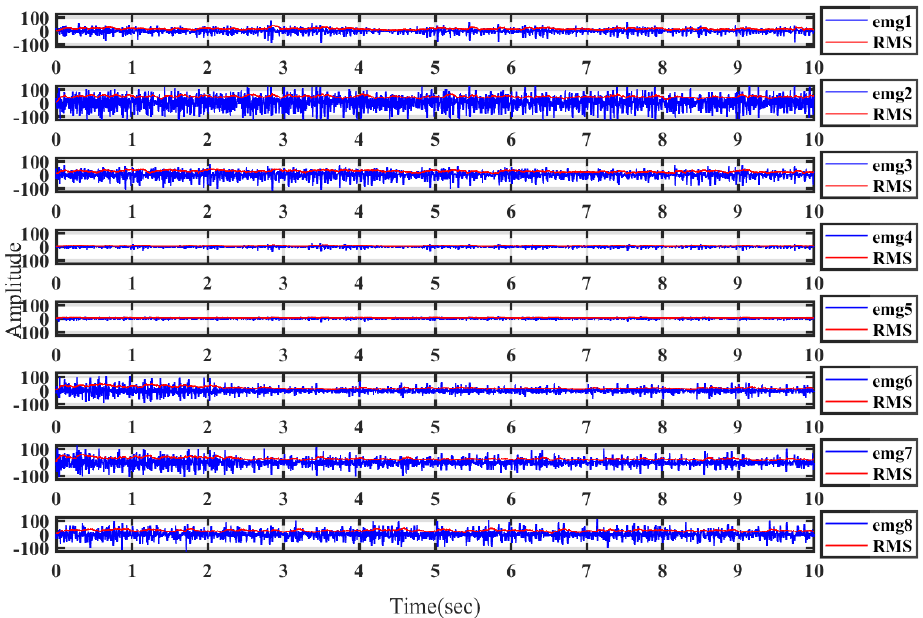
Figure 23. Gesture 2 (spread) maintained for 10 s. The EMG signal and RMS graph of the eight sensors in the sEMG bracelet.